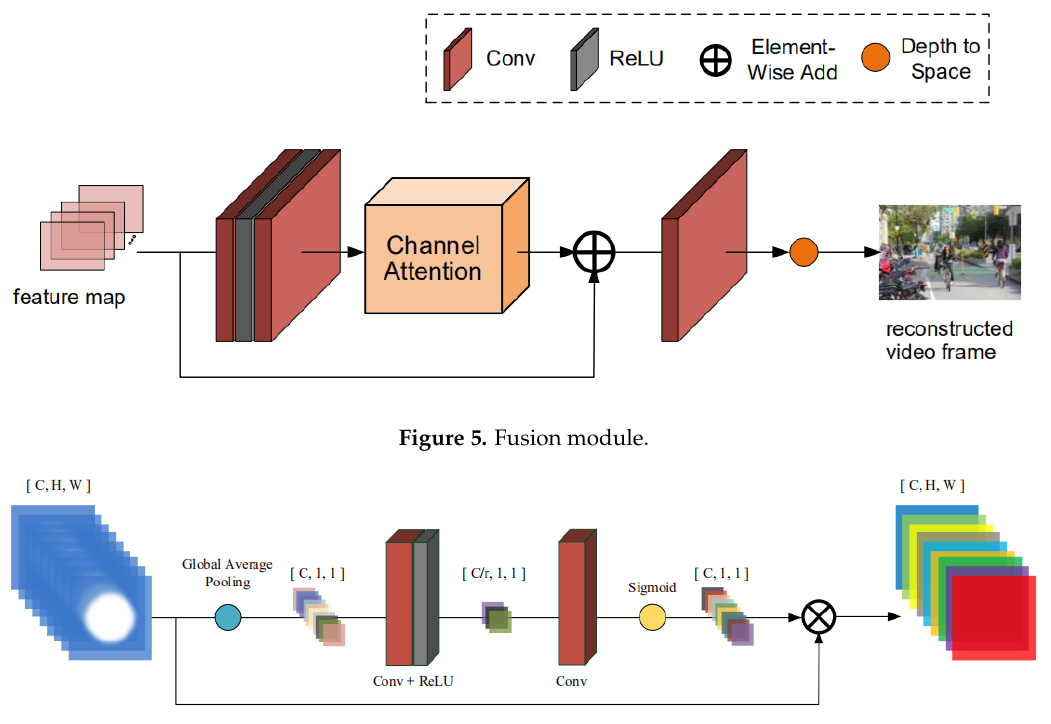
Figure 6. Channel attention mechanism with scaling factor